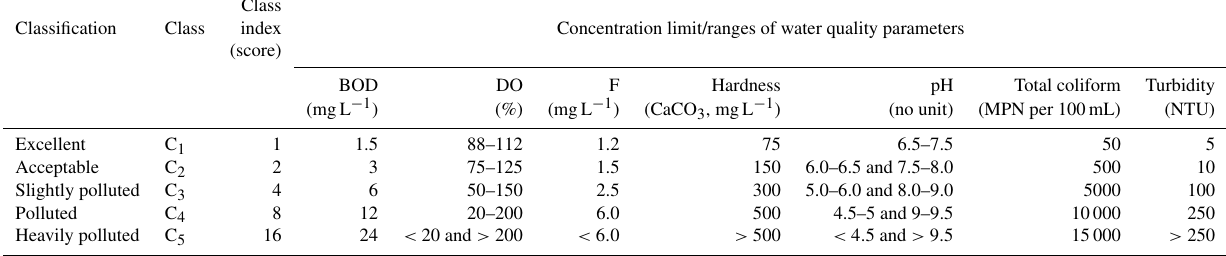
Table 1. Classification scheme of water quality used in OIP (source: Sargoankar and Deshpande, 2003). Class Classification Concentration limit/ranges of water quality parameters (score)